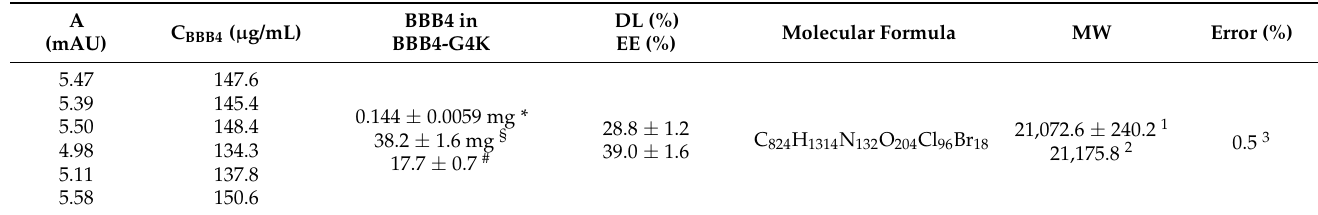
Table 3. Values of A obtained for the six aliquots and the related C BBB4 obtained from Equation (3); results concerning the concentration of BBB4 in BBB4-G4K NPs, DL%, EE%, molecular formula, and MW of BBB4-G4K, as well as the difference between the MW obtained by 1 H NMR and that computed using HPLC results, expressed as error